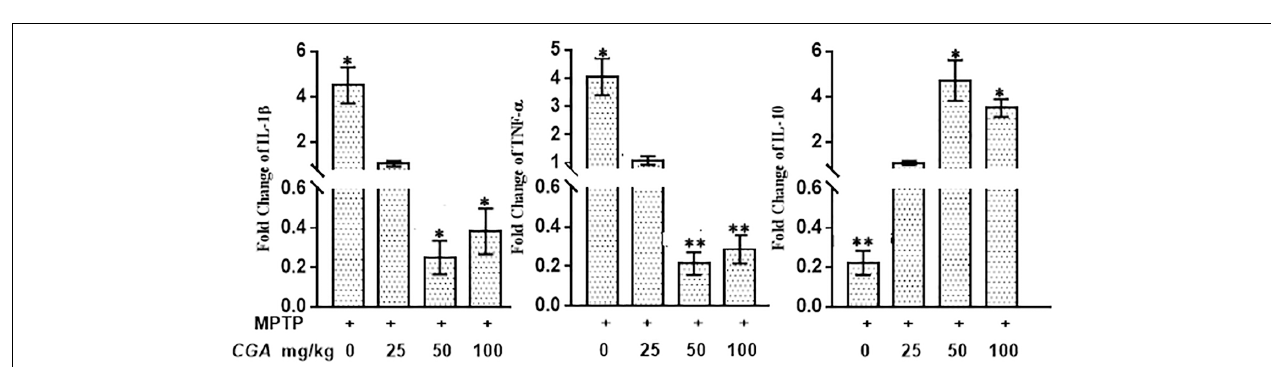
FIGURE 10 | Effect of CGA on mRNA expression levels of inflammatory cytokines: IL-1 β , TNF- α , and anti-inflammatory cytokine; IL-10 in PD mice model. In the absence of CGA, the MPTP-intoxicated mice brain tissue showed significantly enhanced expression levels of TNF- α and IL-1 β with downregulated IL-10 levels compared with that of control. On supplementation with CGA at 50 and 100 mg/kg body weight concentration, the MPTP mice brain tissue showed significantly enhanced expression levels of IL-10 and decreased levels of TNF- α and IL-1 β compared with the untreated MPTP-intoxicated mice. Values in the graph are represented as mean ± SEM with the level of significance ∗ p < 0.05 and ∗∗ p < 0.01. CGA, chlorogenic acid; MPTP, 1-methyl-4-phenyl-1,2,3,6-tetrahydropyridine; SN, TNF- α , tumor necrosis factor; SEM, standard error of